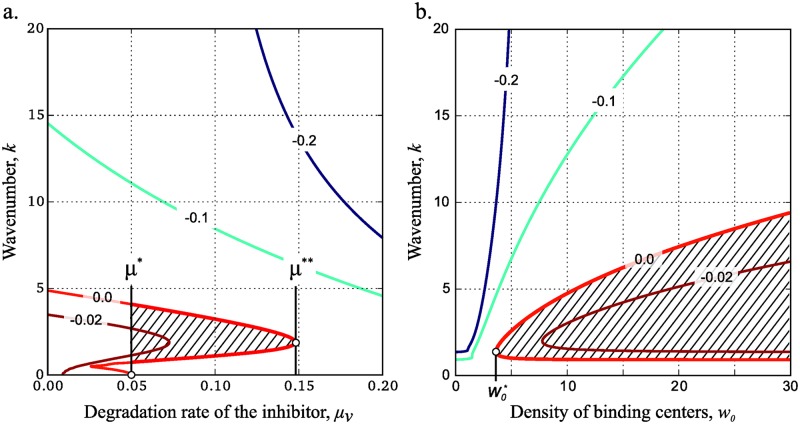
Turing instability for different values of w0 and μv.Level lines of {max Re
λ(k)} for different values of parameters and wave number (see supplementary equation (S1.3.9) for details). By definition, any vertical cross-section of the map gives a dispersion curve (similar to Fig 2). Dashed area indicates parameter values for which real parts of Lyapunov coefficients are positive and thus Turing instability can occur. The following model parameters were used for the development of the maps: k1 = 1, k−1 = 0.1, D = 0.1, ρ = 0.6, μu = 0.05 and w0 = 7 (a) or μv = 0.08 (b).